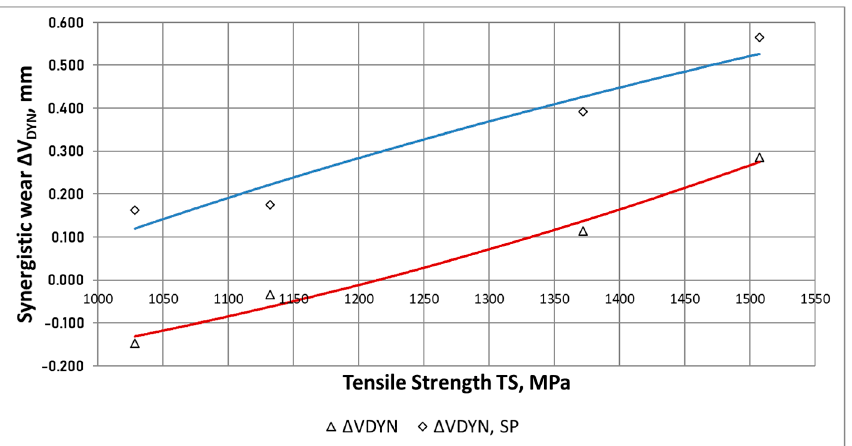
Figure 17. Waveforms of the component Δ W DYN as a function of the maximum strength of the tested ADI.